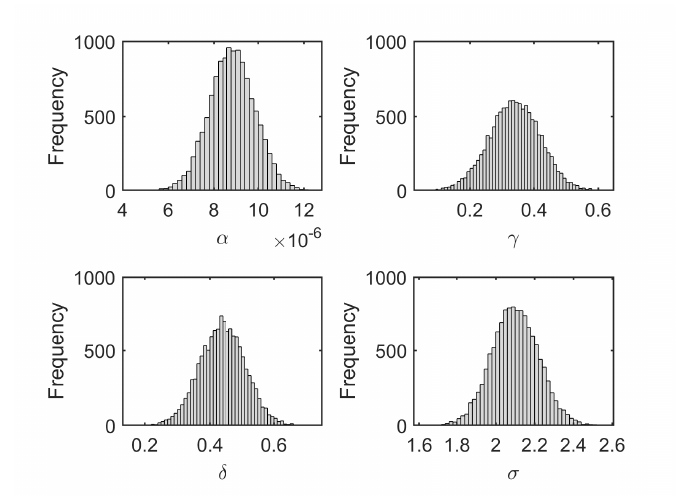
Figure 2. Parameter distributions used for the Monte Carlo method. Twelve thousand samples are used for further comparison.